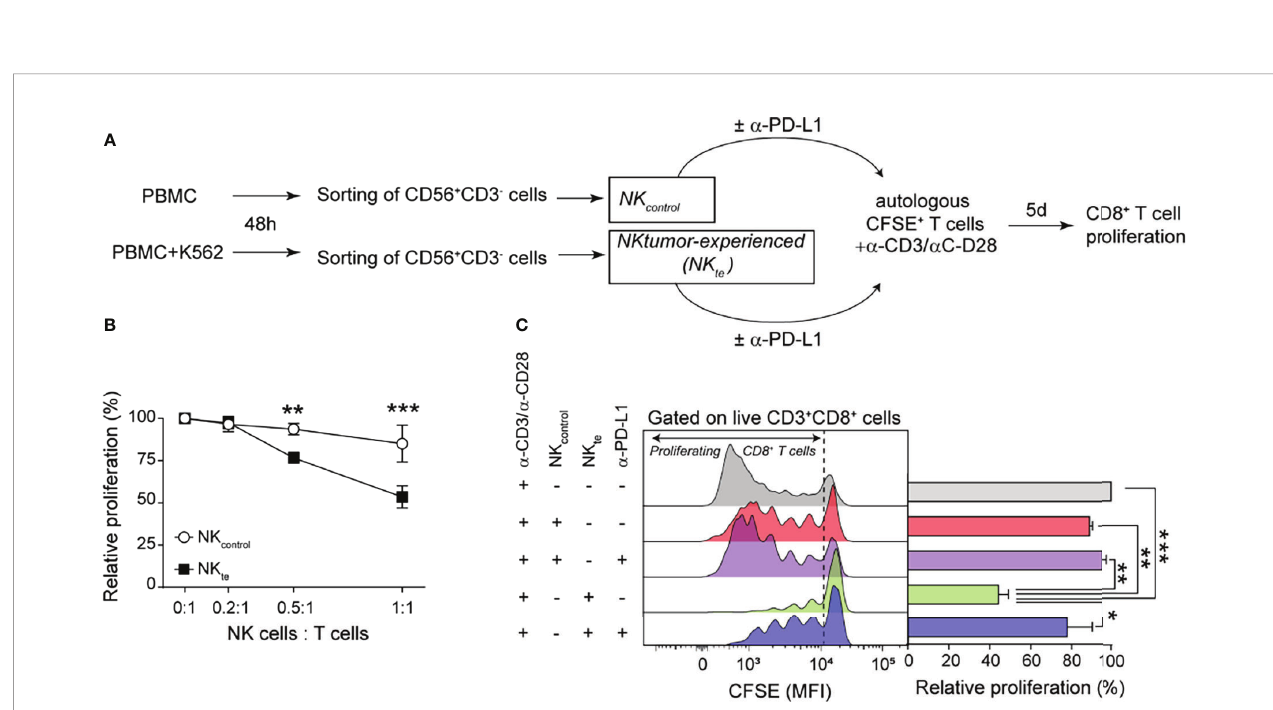
FIGURE 7 | Tumor-experienced NK cells inhibit CD8 + T cell proliferation through PD-L1. (A) Experimental design used to generate control NK cells ( NK control ) and tumor-experienced NK cells enriched in PD-L1 hi cells ( NK te ) to investigate their effect on T cell proliferation. (B) Relative proliferation of CD8 + T cells analyzed by CFSE dilution after stimulation with anti-CD3/anti-CD28 mAb and cultured with increasing numbers of autologous NK control or NK te . (C) Relative proliferation of CD8 + T cells analyzed by CFSE dilution after stimulation with anti-CD3/anti-CD28 mAb in the absence or in the presence of autologous NK control or NK te in the absence or in the presence of an anti-PD-L1 blocking mAb. Representative histograms showing CFSE dilution in live CD3 + CD8 + CD56 - cells are shown (n=3). Data represent mean ± SEM. Two-way ANOVA with Sidak´s post hoc test (B) and one-way ANOVA and Tukey´s post hoc test (C) * p <0.05, ** p <0.01, *** p